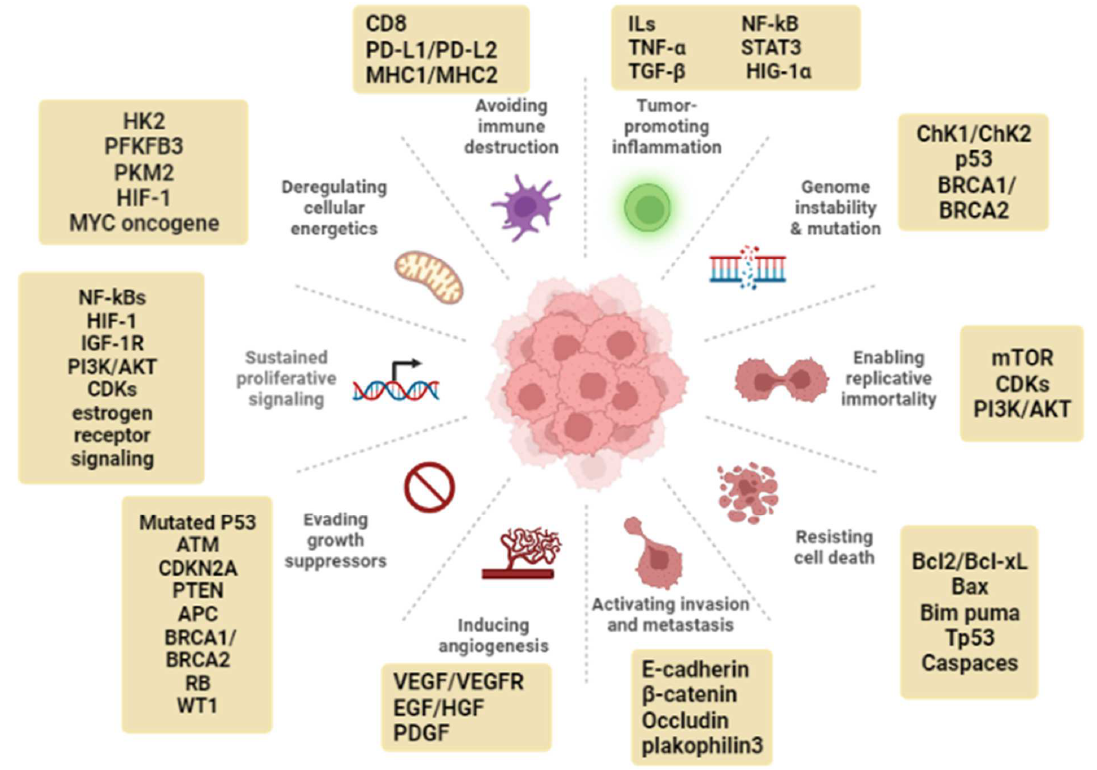
Figure 1. Cancer hallmarks with the main regulatory biomarkers. VEGF, vascular endothelial growth factor; VEGFR, vascular endothelial growth factor receptor; EGF, epidermal growth factor; hepatocyte growth factor; ATM, ataxia-telangiectasia mutated; PTEN, phosphatase and tensin homolog; APC, adenomatous polyposis coli; BRCA1 and BRCA2, breast cancer gene 1 and 2; RB, retinoblastoma; WT1, Wilms tumor; CDKs, cyclin-dependent kinase; IGF-1R, insulin-like growth factor receptor; HIF-1, hypoxia-inducible factor-1; HK2, hexokinase 2; PKM2, pyruvate kinase isoform M2; PFKFB3, 6-phosphofructo-2-kinase/fructose-2,6-biphosphatase 3; PD-L1, programmed death ligand 1; MHC, major histocompatibility complex; CD8, cluster of differentiation 8.